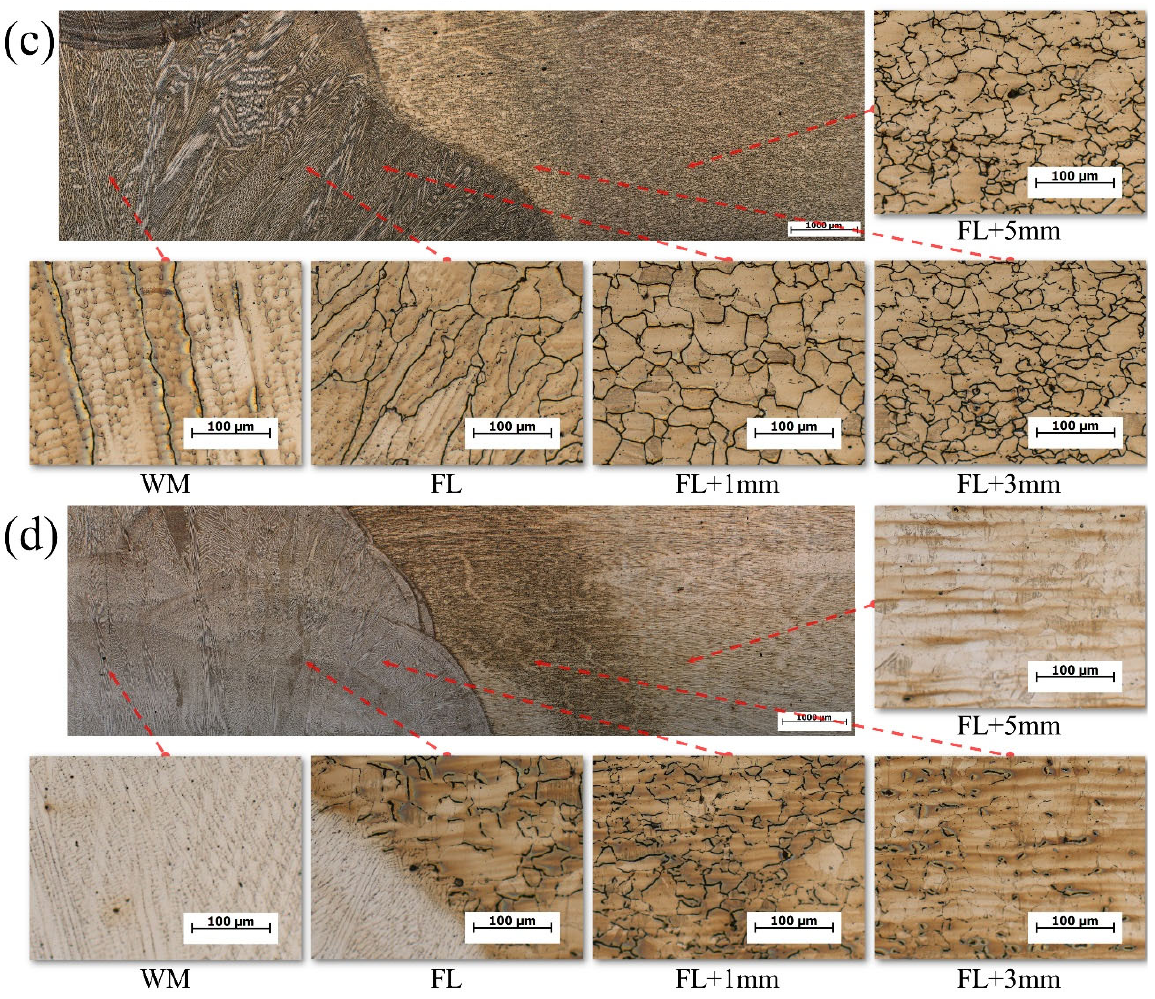
Figure 10. Microstructure of the welded joints: ( a ) SM ‐ 1; ( b ) SM ‐ 3; ( c ) SA ‐ 1; ( d ) GT ‐ 1.